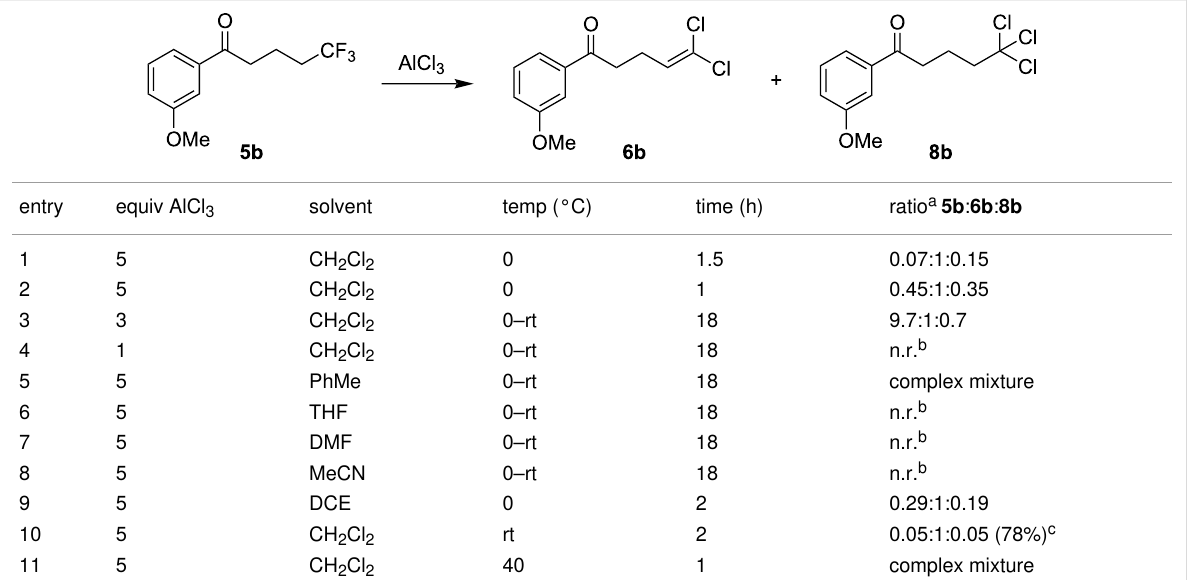
trichloroalkanone 8b , but at the expense of the formation of a number of other unidentified byproducts (Table 1, entry 11). At room temperature, the right balance of starting material conver- sion and minimisation of byproduct formation was reached, so that dichloroalkenone 6b could be isolated in 78% yield (Table 1, entry